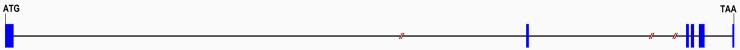
Schematic representation of the gene structure of BmYki.The exons(blue boxes) and introns(black lines) are shown. Double slashes indicate gaps in genomic sequences. The length of exon 1 ~ exon 6 is 473, 143, 141, 158, 303, and 96 bp, respectively.